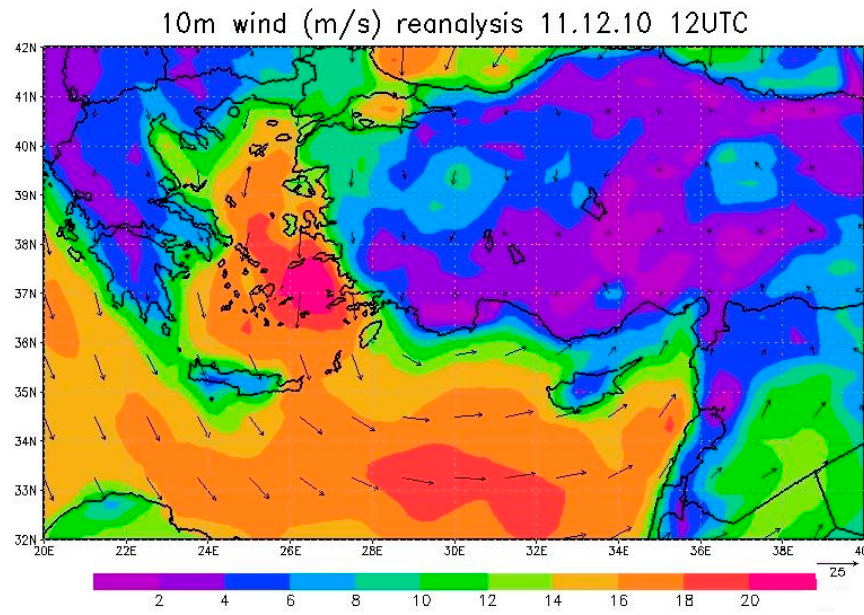
Figure 9. 10 m wind on 11 December 2010 12:00 UT at the peak of the secondary low in the reanalysis [20]. Wind speed contours in m s − 1 . 3. Model Configuration and Experimental Design In this study we use the limited area Regional Spectral Model (RSM) which was de- veloped at the National Centers for Environmental Prediction (NCEP) [24–26] based on the structure of the NCEP Global Spectral Model (GSM), which was the operational fore- cast model at that time. The GSM was also the model used to generate the NCEP Reanal- ysis-1 (R1) and Reanalysis-2 (R2) [27] global data sets and therefore the RSM has a nearly seamless interface with R1 and R2 for downscaling.